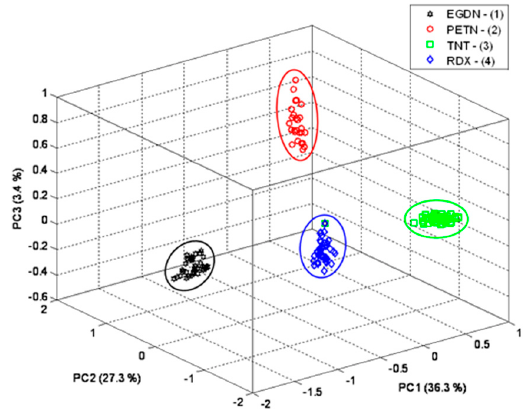
Figure 6. PCA 3D score plot of PC1 vs. PC2 vs. PC3 for the SERS spectra dataset. The three components account for 67% of the spectral variation.